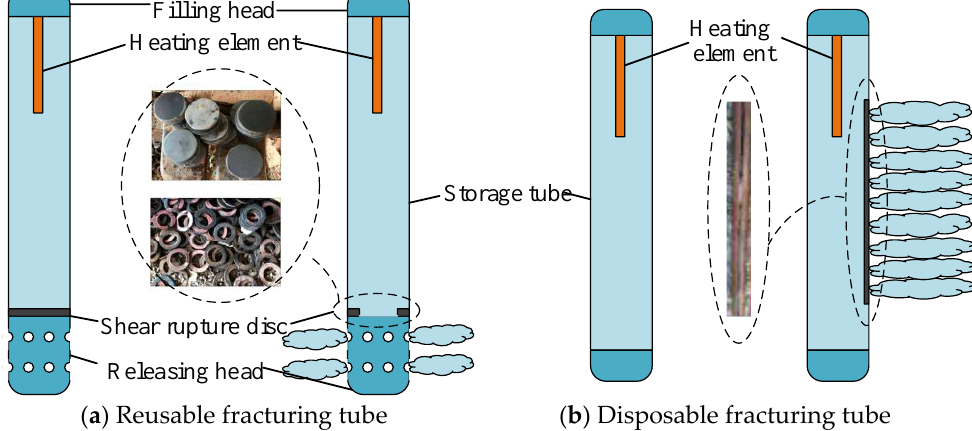
Figure 2. Structure diagram and jet characteristics of different phase change blasting devices.